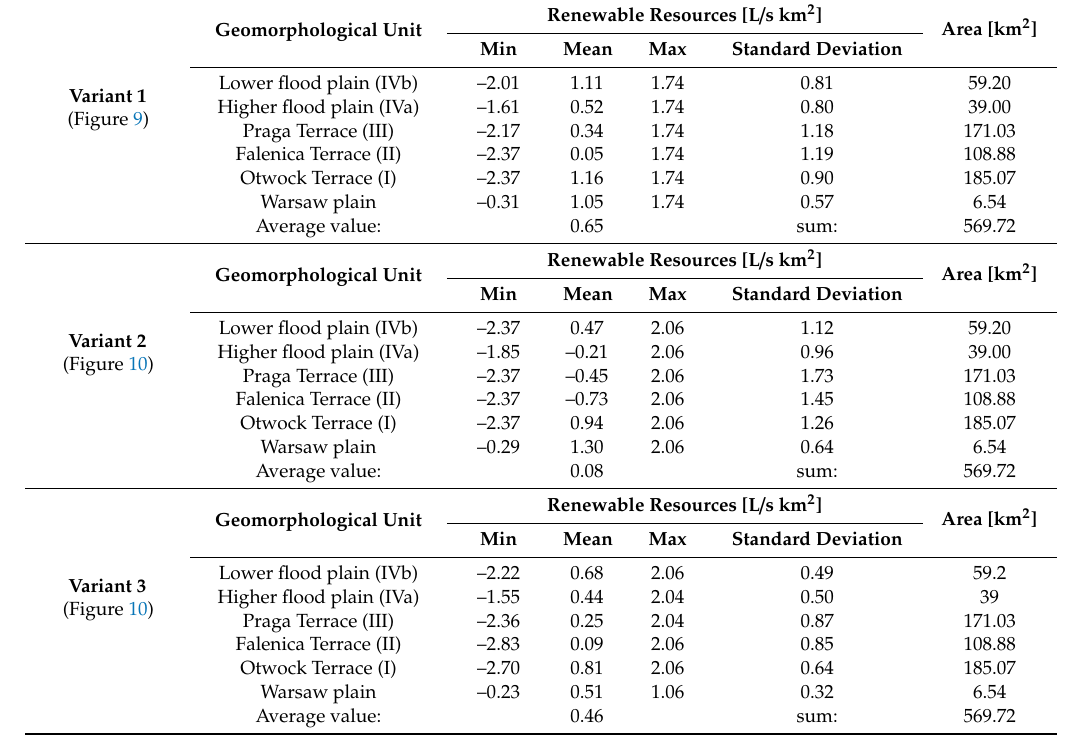
Table 4. Changes of groundwater resources in groundwater model